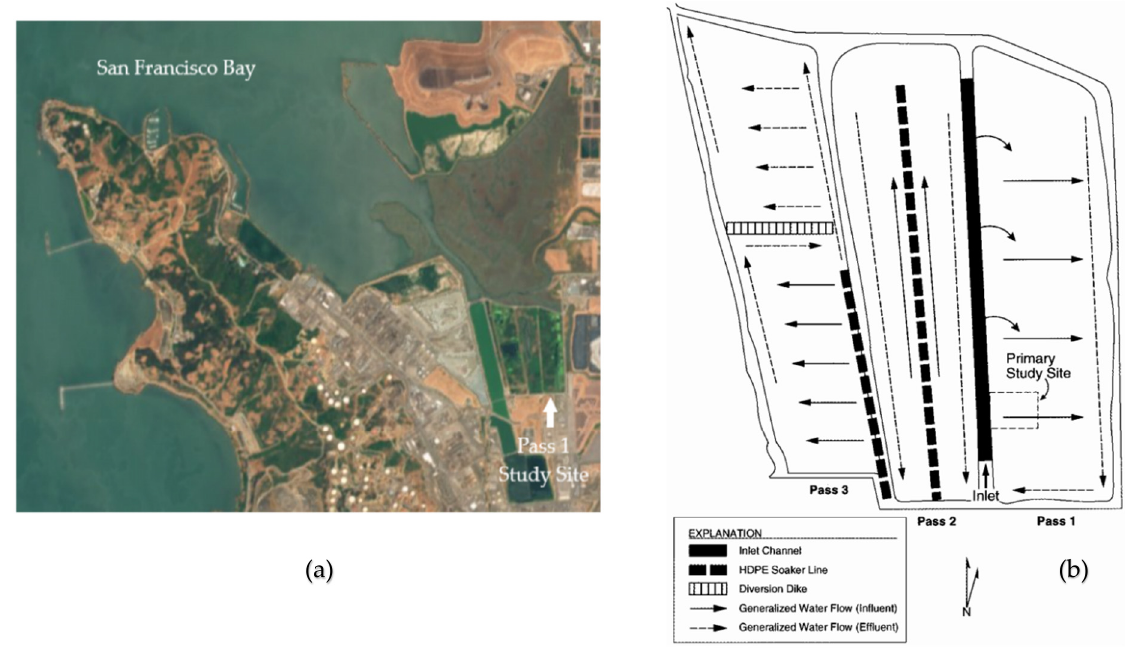
Figure 1. ( a ) The Chevron wetland in relation to San Francisco Bay; ( b ) schematic of the wetland showing generalized water flow and location of the primary study site in Pass 1.